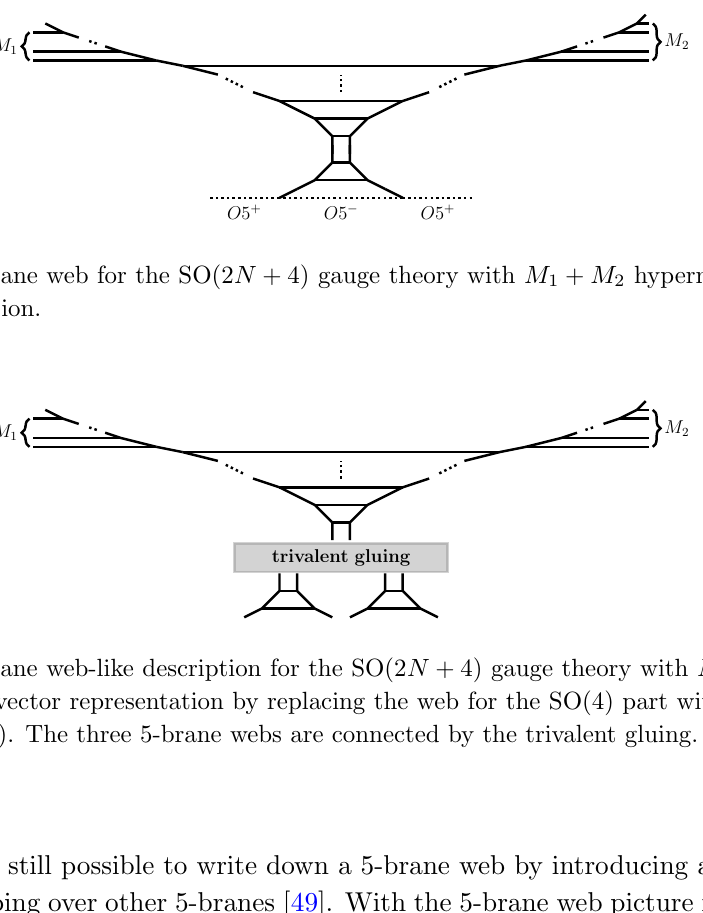
(cid:12)gure 4 but it is still possible to write down a 5-brane web by introducing a